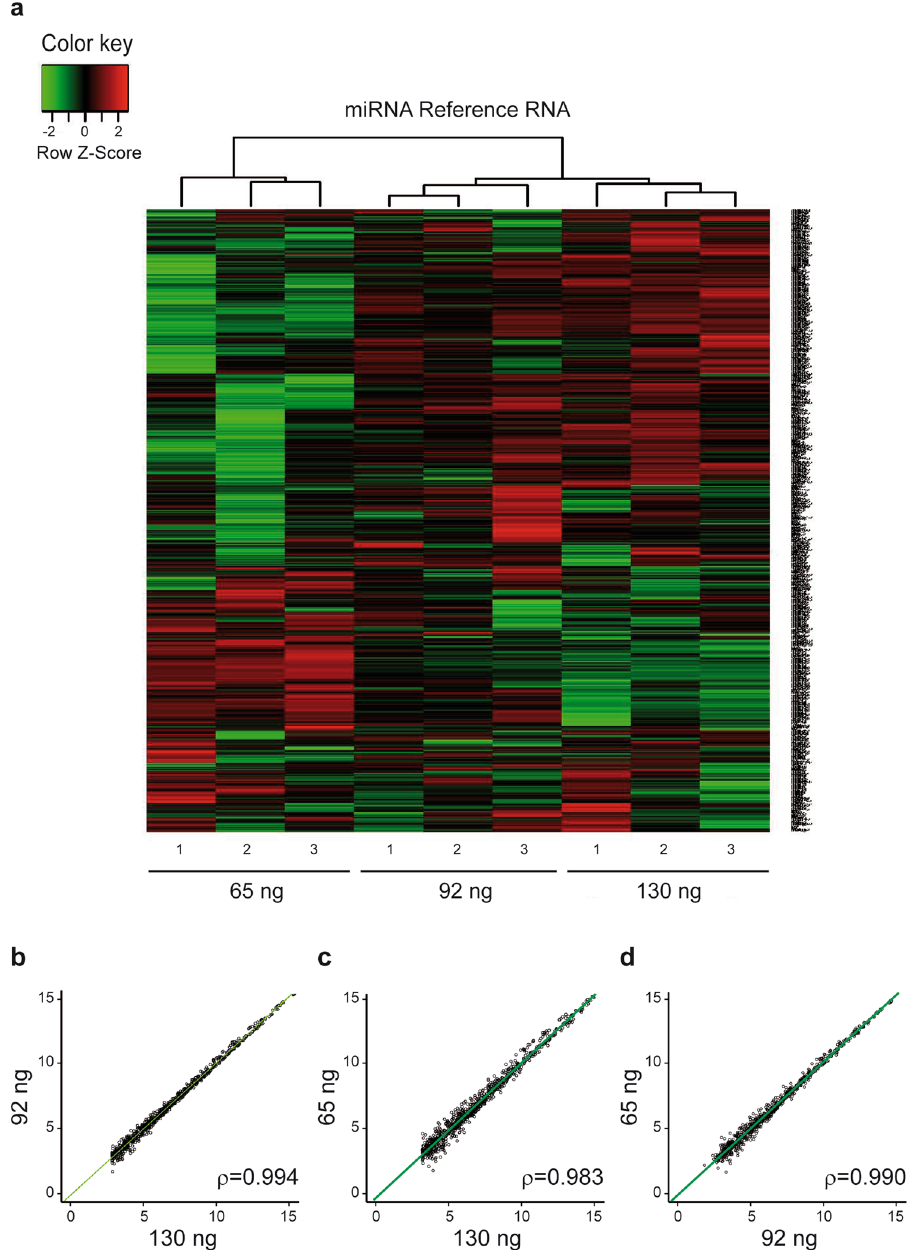
Figure 5. miRNA Reference RNA hybridization microarrays. ( a ) Heat maps obtained from three 130/, 92/and 65/miRNA-Ref hybridization microarrays. Only miRNA with significant expression ( > 3) in the 130 ng sample and observed in all three arrays are represented. ( b ) Correlation between the miRNA profiles of the mean of the triplicates for the three starting amounts. The regression line is represented as a solid green line. Axis units are expressed in log2